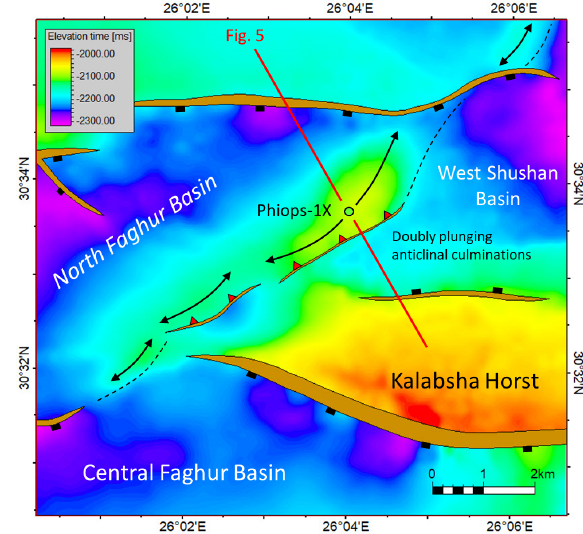
Figure 6. Detailed top Khatatba Fm time structure map of the Phiops inversion trend. Other wells have been removed for clarity. See Fig. 4 for location and legend. Position of Fig. 5 is